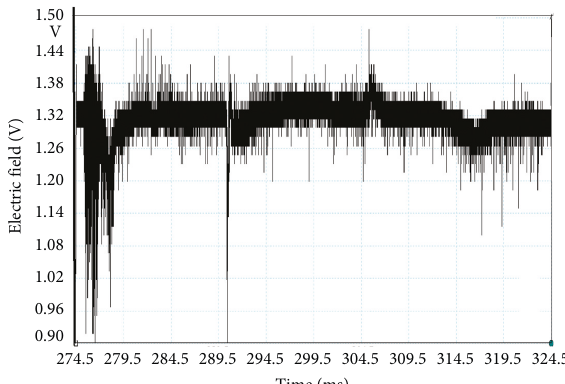
Figure 11: An expansion of the third stage of three-stage typical cloud flash of Figure